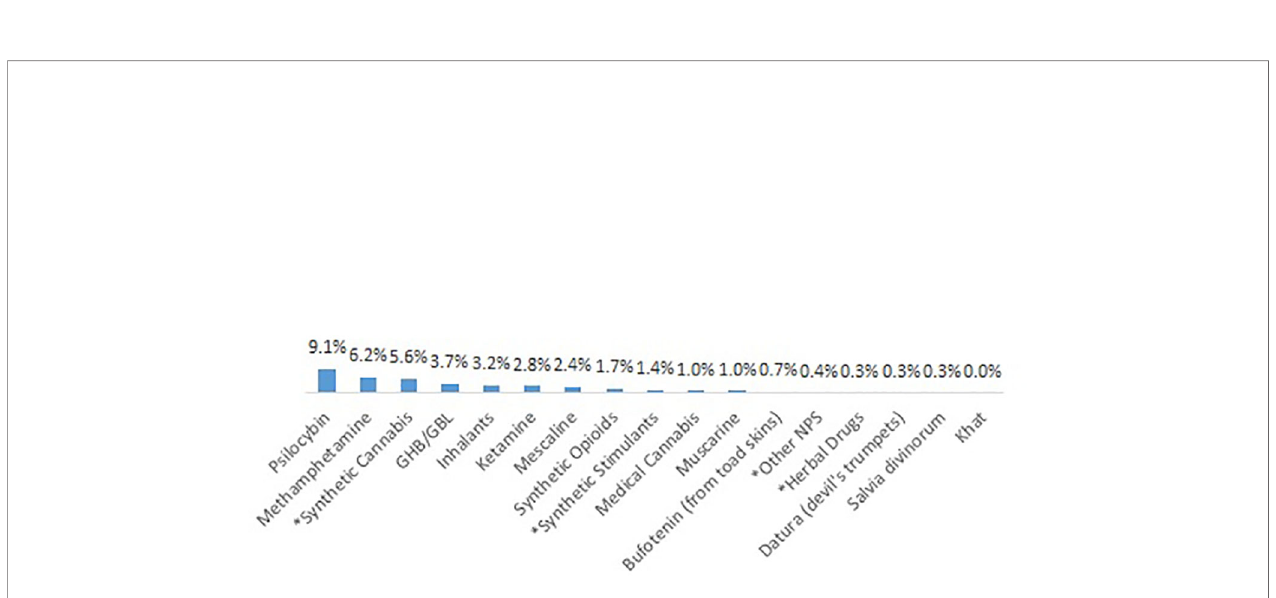
FIGURE 4 | Other substances used regularly during ifetime, including *NPS.